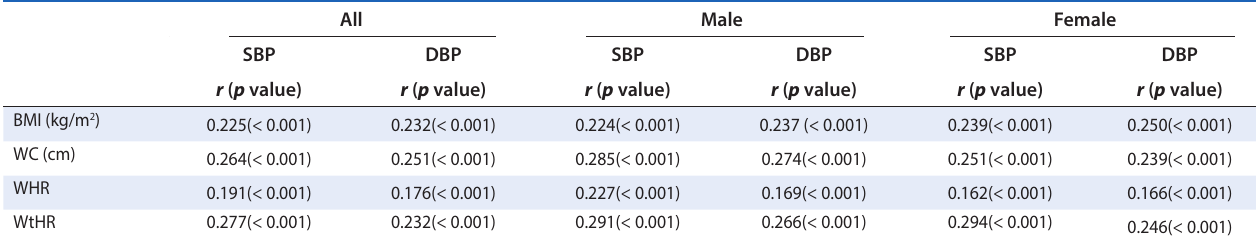
Table 3: Sex differences in correlates of obesity indices and BP